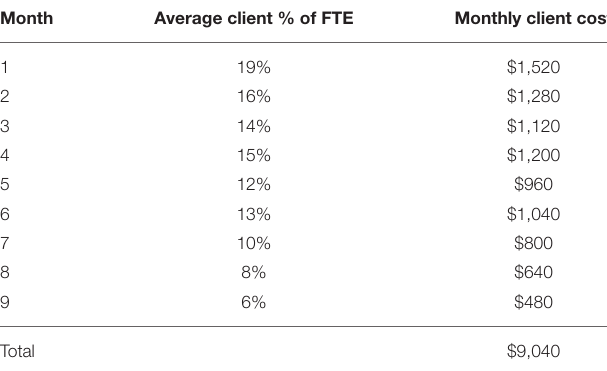
TABLE 4 | Average cost of treatment per client, per treatment